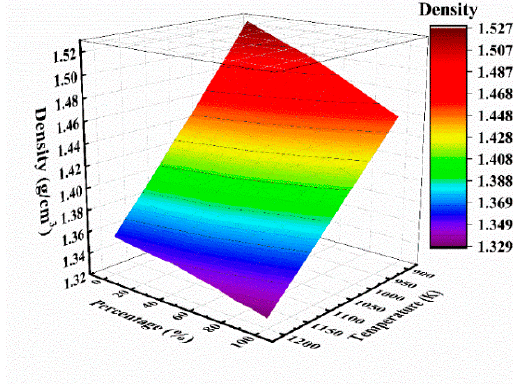
Figure 7. Surface map of simulated density results.